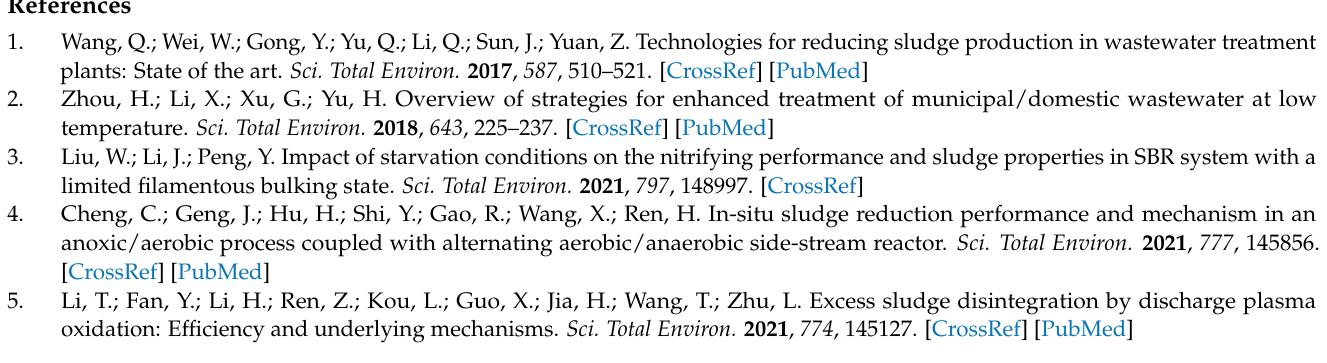
Figure S2: The temporal variations of NO 3 − -N and NH 4+ -N in different tanks of MBR control , AOA 90 , and AOA 80 ; Figure S3: The MLSS concentration in different units of MBR control (a), AOA 90 (b), and AOA 80 (c); Figure S4: The average polysaccharide and protein in SMP in different units of MBR control (a and b), AOA 90 (c and d), and AOA 80 (e and f); Figure S5: EEM-PARAFAC components, tryptophan-like (C1), fulvic-like (C2), and humic-like (C3); Figure S6: The relative abundance of functional genes responsible for nitrogen metabolism in MBR control (A), AOA 90 (B), and AOA 80 (C) (The subscript of A, B, and C means the sampling time). Table S1: Chemical composition of synthetic wastewater; Table S2: The average ± standard deviation of basic quality parameters of effluent in three different bioreactors ( n = 25); Table S3: The average of NH 4+ and NO 3 − in the supernatant of different treatment units of MBRs (n = 14); Table S4: Sequencing of bacterial 16S rRNA gene along with alpha diversity of microbial taxa in three